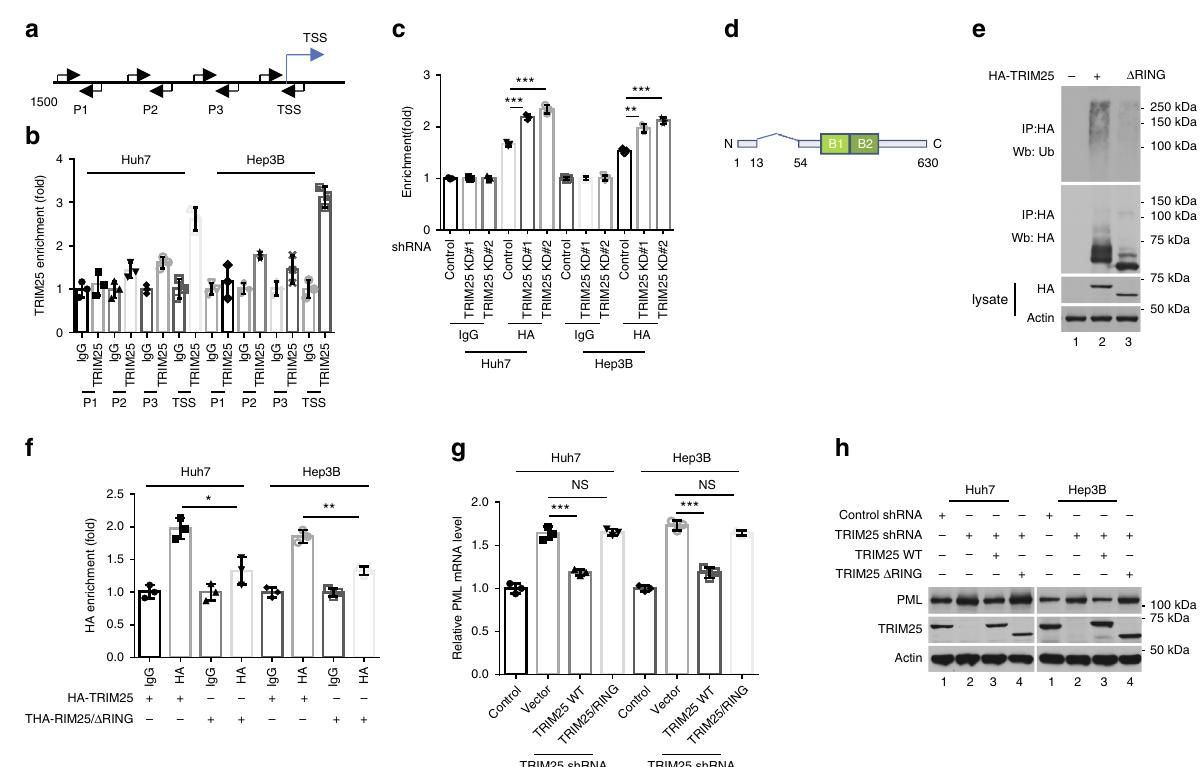
Fig. 5 Transcriptional activity of TRIM25 was regulated by the RING domain. a Schematic diagram of the ChIP-qPCR analysis of the PML promoter regions. P, promoter; TSS, transcription start site. b RT-PCR on ChIP samples was carried out at the indicated four regions (P1, P2, P3, and TSS). Fold enrichment represents the accumulation of TRIM25 compared with an IgG control on the target. Data represent the means ± SD of three independent experiments. c The recruitment of IRF-8 to the PML promoter was promoted after TRIM25 knockdown. *** p = 0.0002 (siControl versus siTRIM25 #1 in the Huh7 cells), *** p = 0.0002 (siControl versus siTRIM25 #2 in the Huh7 cells), ** p = 0.0010 (siControl versus siTRIM25 #1 in the Hep3B cells), *** p = 0.0002 (siControl versus siTRIM25 #2 in the Hep3B cells), two-tailed unpaired t -test. d Schematic representation of the TRIM25 RING domain deletion construct used in e – h . e RING deletion inhibited ubiquitination of TRIM25. f The RING domain was crucial for the recruitment of TRIM25 to the target. Fold enrichment indicates the recruitment of HA-TRIM25 compared with that of an IgG control. Data show the means ± SD of three biological independent experiments. * p = 0.0131 (TRIM25 versus TRIM25/ △ RING in the Huh7 cells), ** p = 0.0014 (TRIM25 versus TRIM25/ △ RING in the Hep3B cells), two- tailed unpaired t -test. g , h Complemental TRIM25 but not TRIM25/ Δ RING suppressed PML expression in TRIM25 depleted cells. TRIM25 was depleted by a 3 ʹ -untranslated region (UTR)-targeting shRNA. Data represent the means ± SD; n = 3. *** p = 0.0006 (Vector versus TRIM25-WT in the Huh7 cells), *** p = 0.0003 (Vector versus TRIM25-WT in the Hep3B cells), two-tailed unpaired t -test. NS, non-signi fi cance. Source data are provided as a Source Data fi